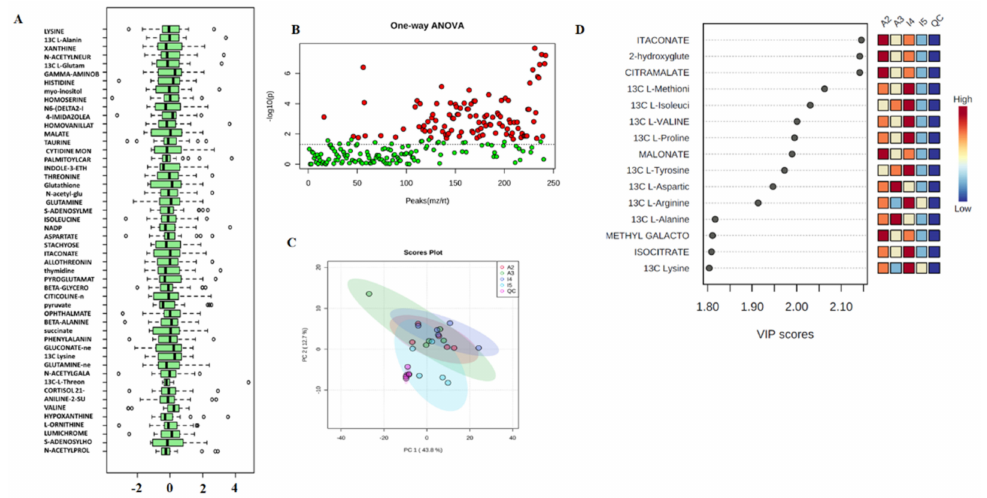
Figure 2. Data processing and normalization the metabolomic data from plasma samples. ( A ) Box- plots and kernel density plots before and after normalization. The boxplots show at most 50 features due to space limitations. The density plots are based on all samples. Selected methods: row-wise normalization: N/A; data transformation: N/A; data scaling: autoscaling. ( B ) Important features selected by ANOVA with a p value threshold 0.05. ( C ) Score plot between the selected PCs. The explained variances are shown in brackets. ( D ) Important features identified by PLS-DA. The colored boxes on the right indicate the relative concentrations of the corresponding metabolites in each group under